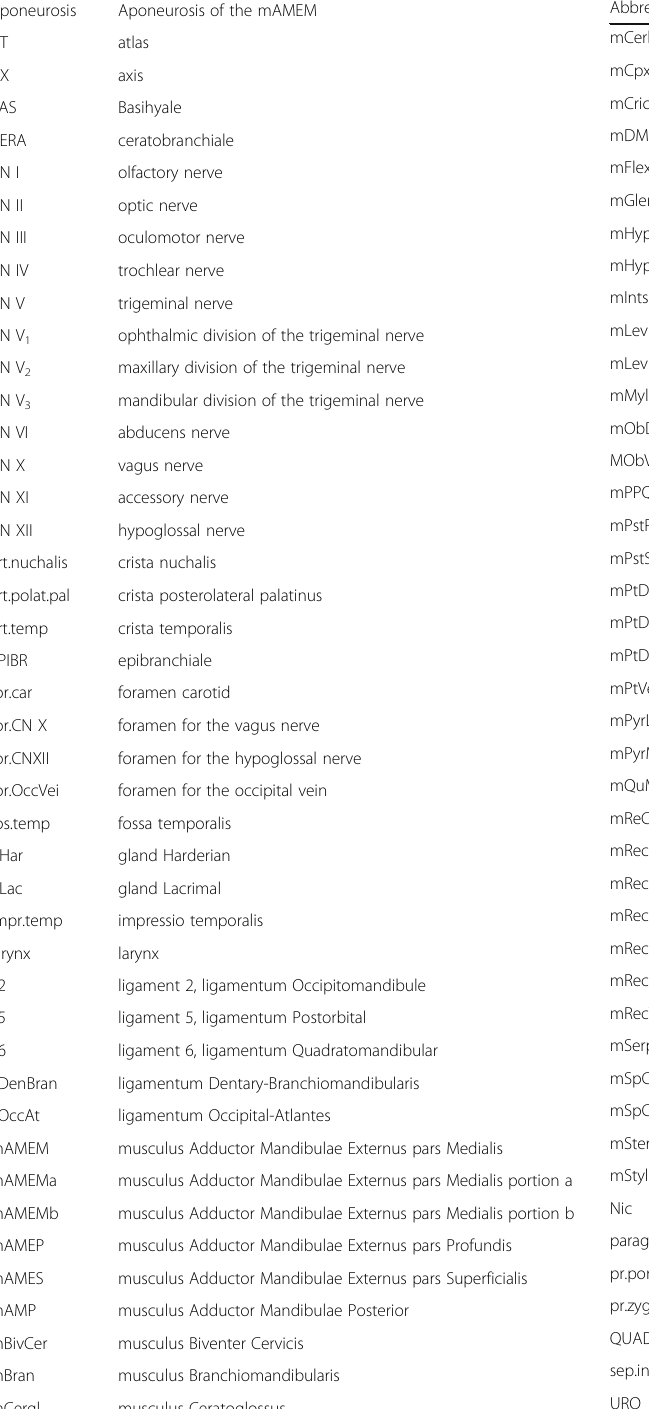
Table 2 Abbreviations used throughout the figures and manuscript text. Bones are in all uppercase. Muscles and glands are in title case following a lower case m or g, ligaments are in title case following a capital L, and specific features are all lowercase with abbreviations separated by a full